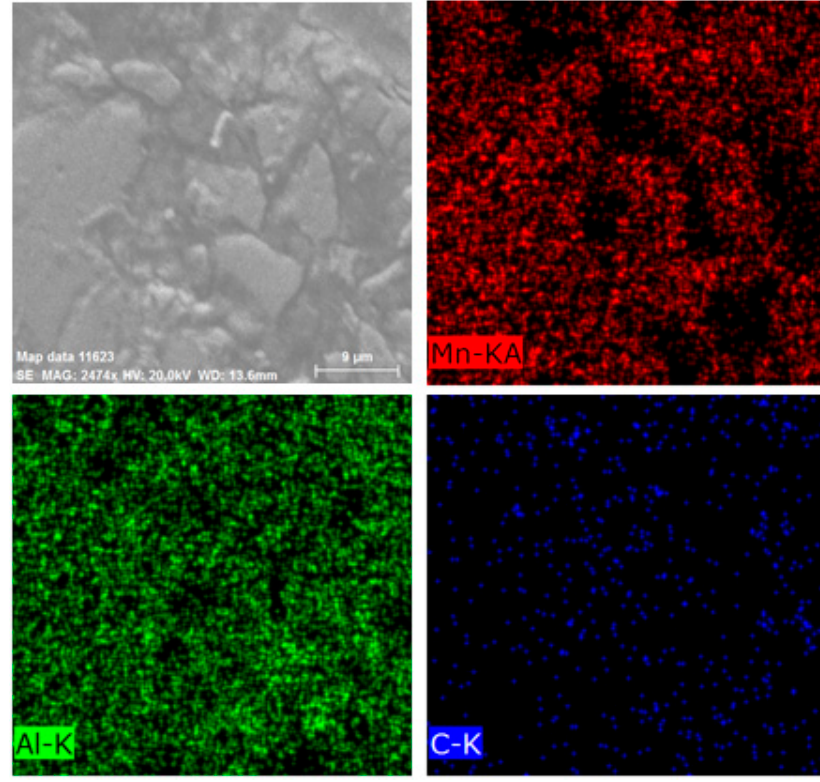
Figure 5. Morphology and mapping images of milled sample in the barrel container.